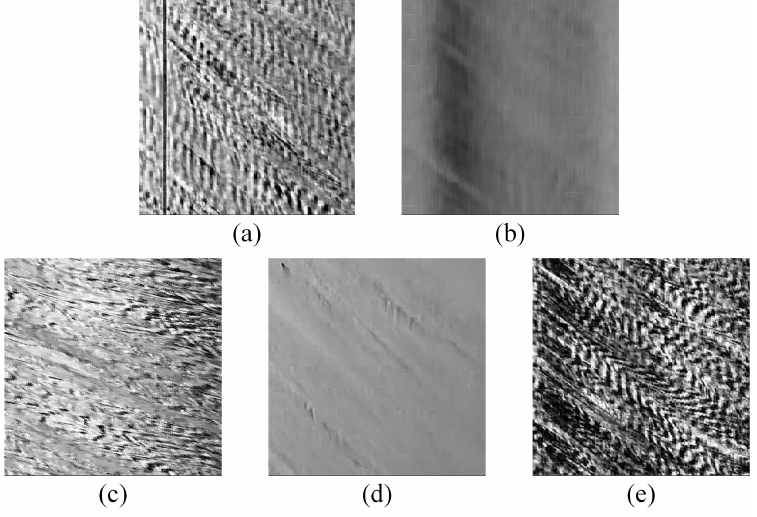
Figure 13. STI in different scenes: ( a ) obstacle ( b ) blur ( c ) flare ( d ) turbulence ( e )